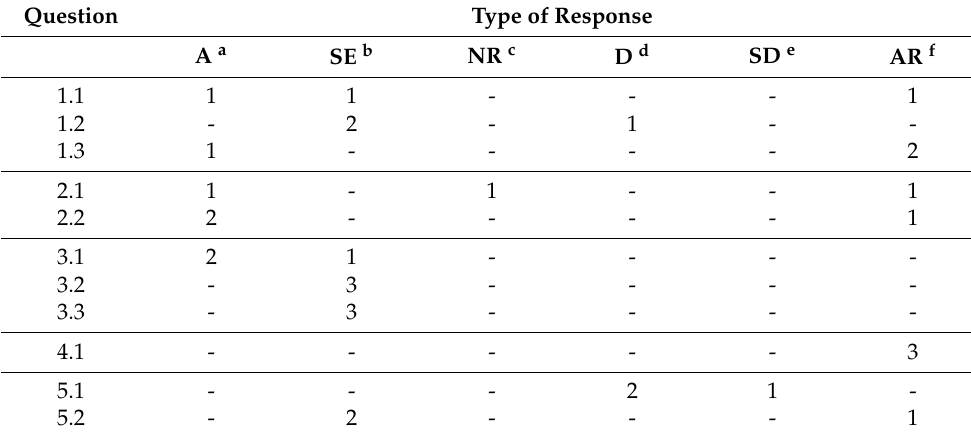
Table 4. Participants’ responses in the education pilot